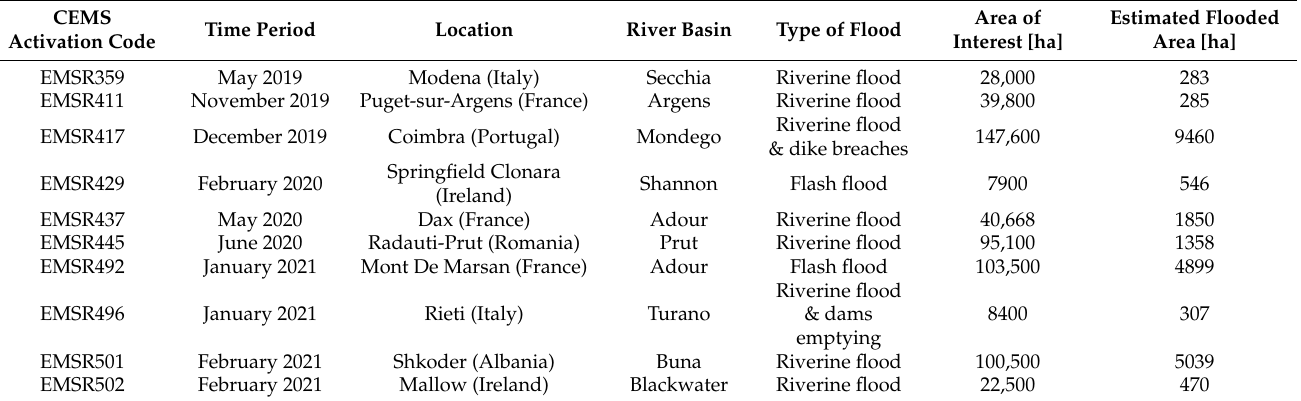
Table 2. Test cases considered in this study for open water mapping.